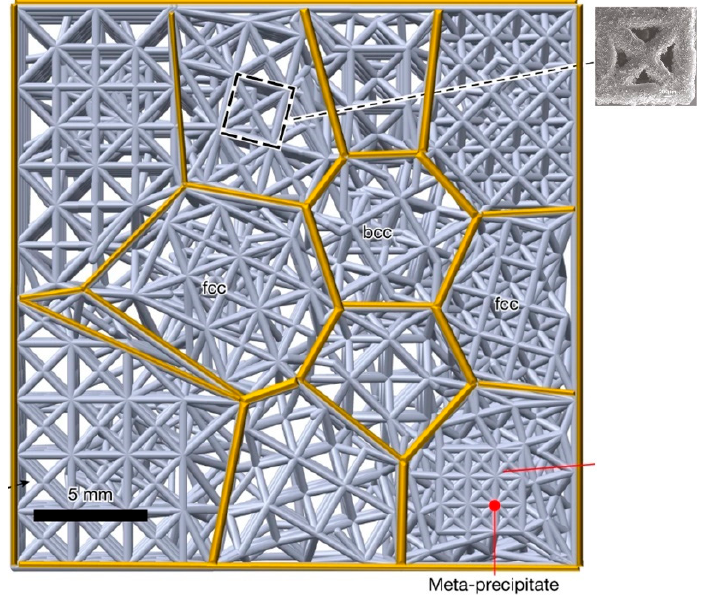
Figure 40. The lightweight structure of Voronoi is combined with lattice [109].